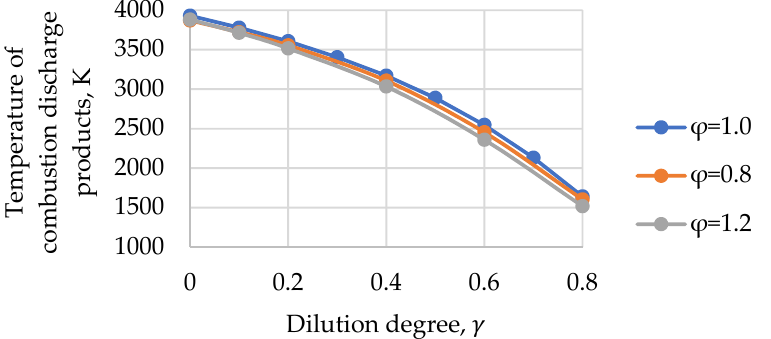
Figure 4. Change of adiabatic temperature of combustion discharge products at ϕ = 1.0, ϕ = 0.8, and ϕ = 1.2.